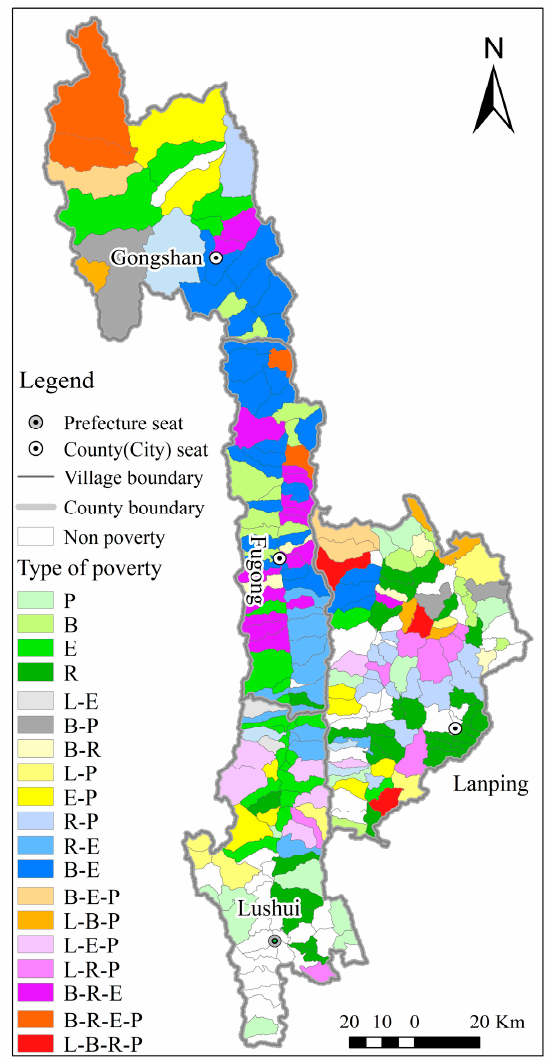
Figure 5. Distribution of relative poverty restriction types in Nujiang Prefecture.